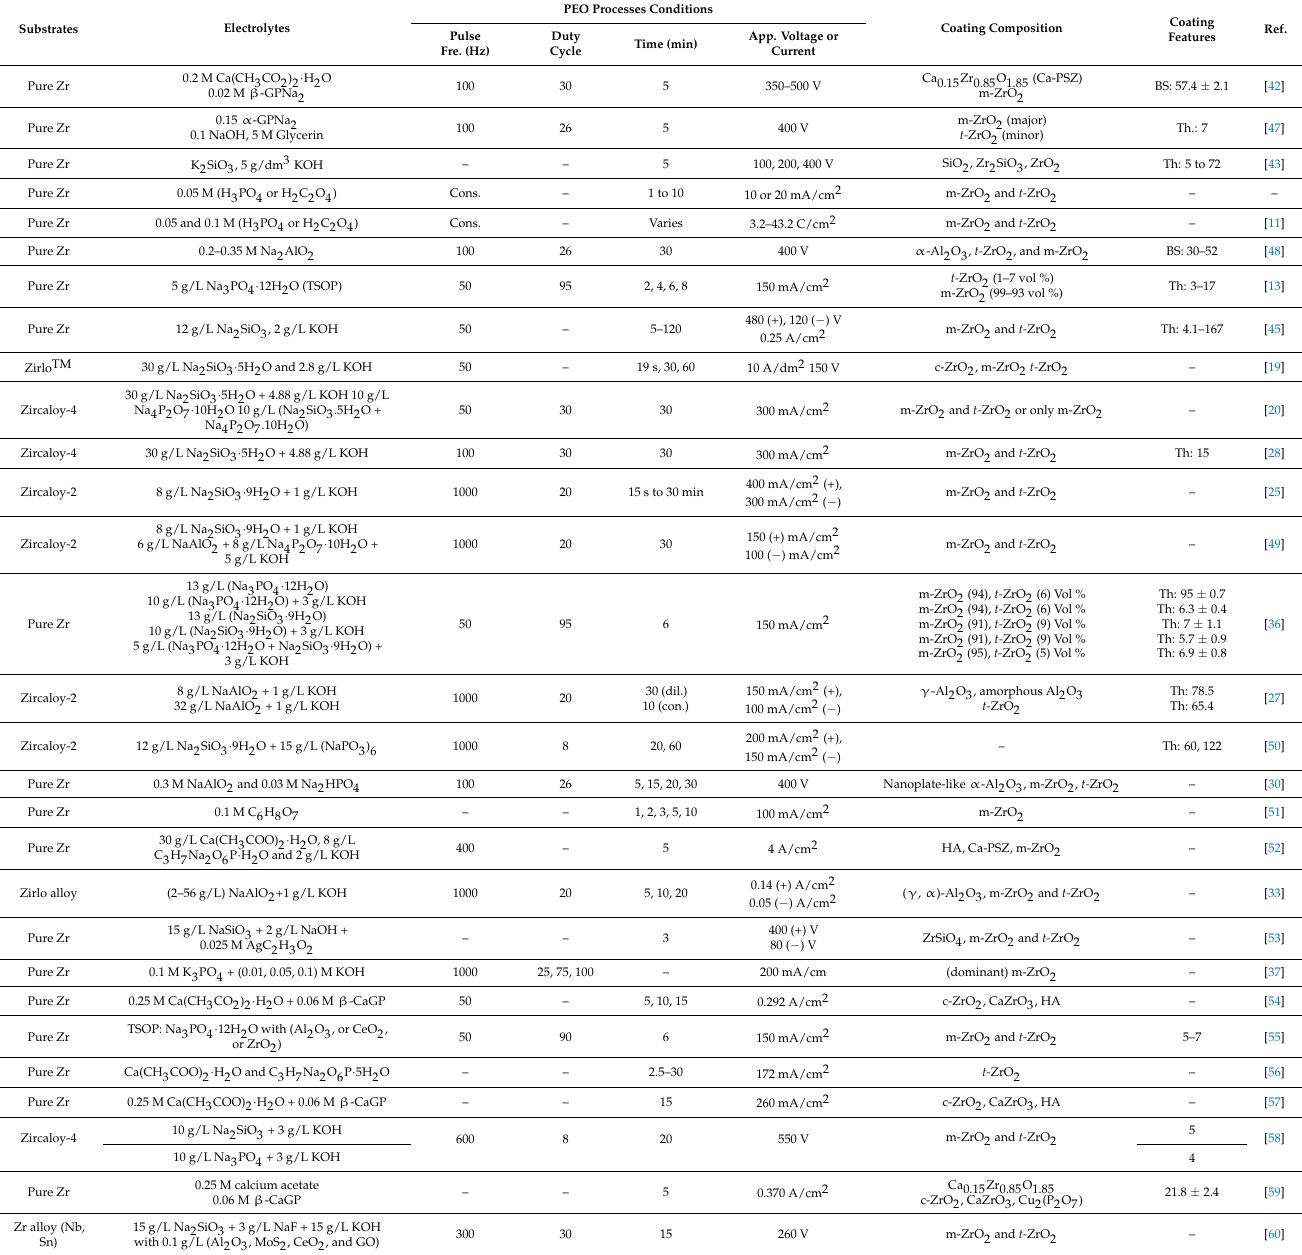
Table 1. PEO process on Zr and Zr alloys representing different processing